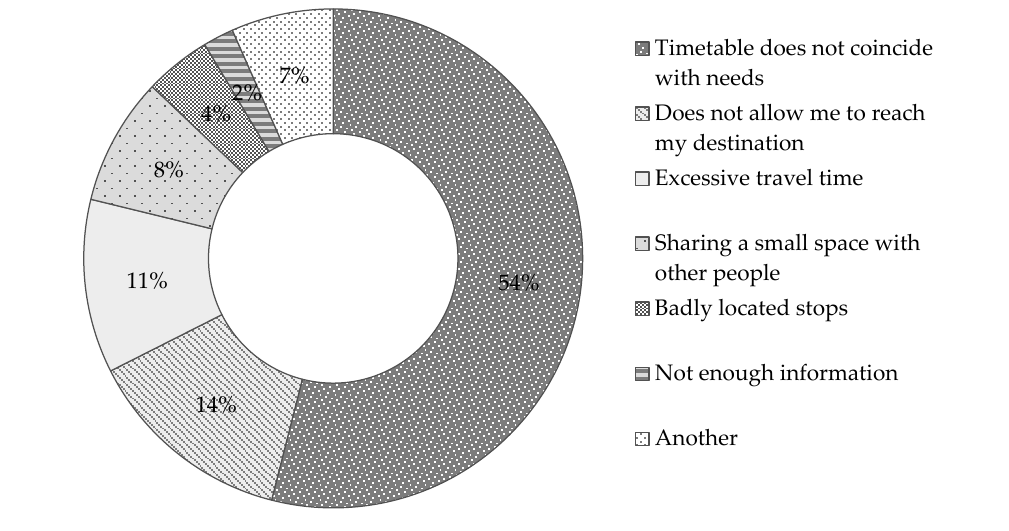
Figure 15. Disadvantages of public transport in the RMSC.